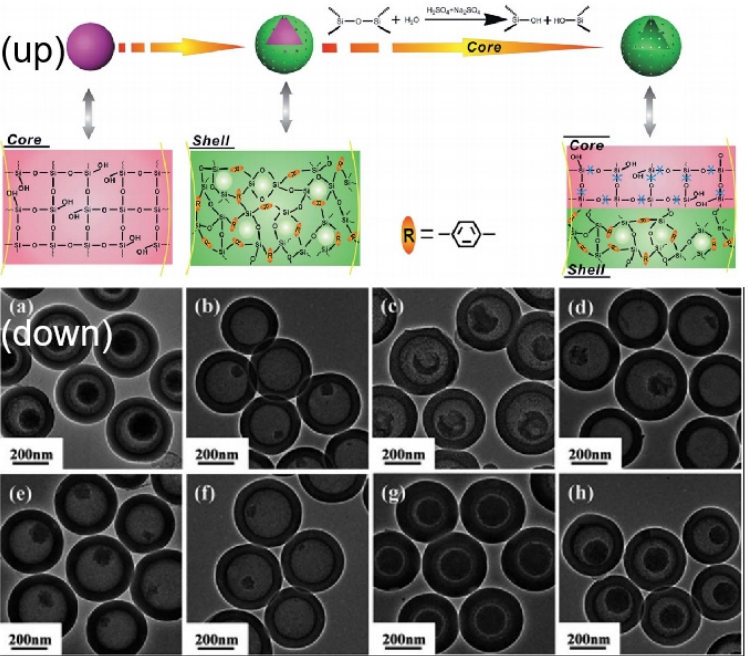
Figure 5. ( Up ) Schematic illustration of the structural difference between the sSiO 2 core and mSiO 2 (moSiO 2 ) shell, and the synthetic procedure for HMOVs employing the acid etchants (H 2 SO 4 and Na 2 SO 4 ). ( Down ) TEM images of RMOVs converted from sSiO 2 @moSiO 2 by H 2 SO 4 plus Na 2 SO 4 etching for varied hydrothermal time durations. Reproduced with permission from Ref. [86], Copyright 2015, Royal Society of Chemistry.